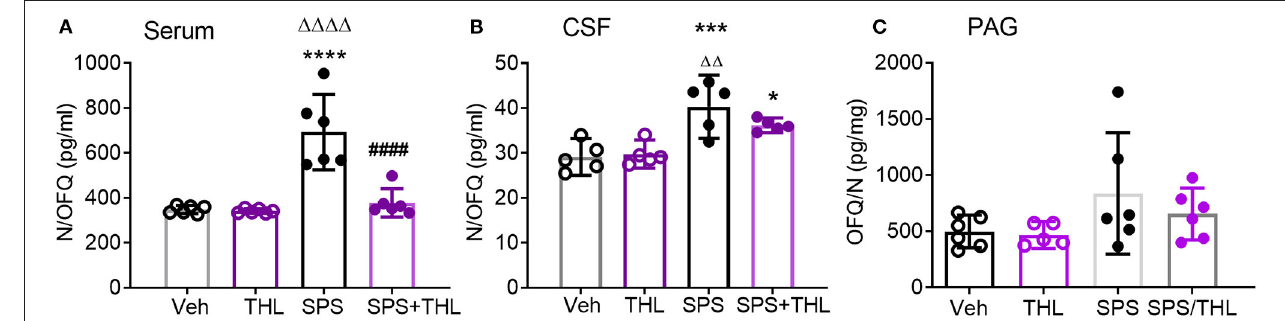
FIGURE 3 | THL reduces SPS-induced increases in serum (A) and CSF N/OFQ (B) , but not PAG (C) . Data are presented as scatter plots with mean ± 95% CI. N/OFQ levels increased in serum ( A , **** p < 0.0001) and CSF ( B , *** p < 0.001) following SPS, THL treatment reversed N/OFQ increase in both serum and CSF ( #### p < 0.0001) as determined by two-way ANOVA with Tukey’s multiple comparisons post-hoc tests. SPS also differed from THL ( 1111 p < 0.0001, 11 p < 0.01). (C) A significant effect of SPS exposure on N/OFQ levels in PAG was observed [ F (1, 19) = 4.442, p = 0.04], but no post-hoc differences were found. Rout outlier test excluded one rat from THL (C) , Q =